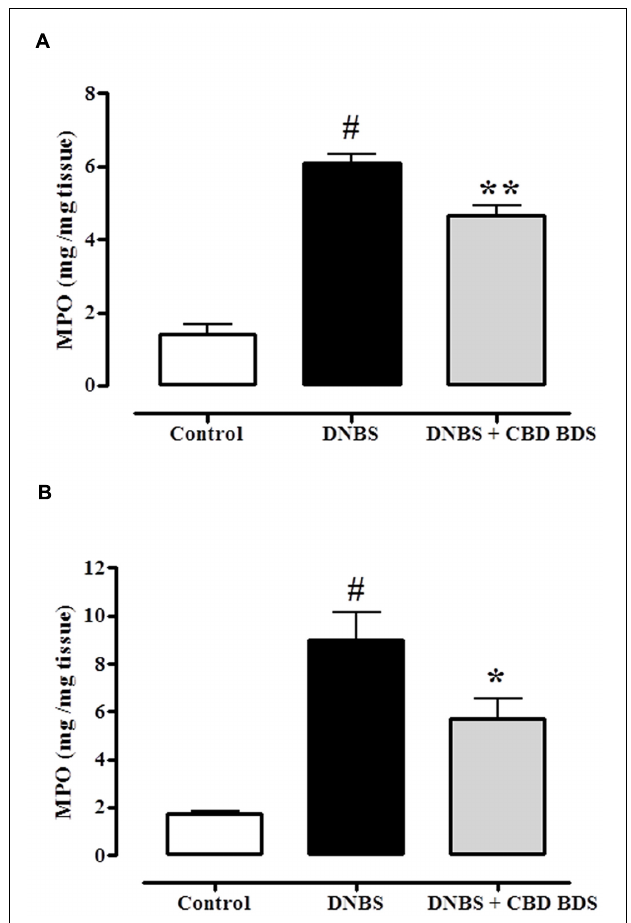
FIGURE 3 | Inhibitory effect of CBD BDS 30 mg/kg, intraperitoneally (A) and CBD BDS 60 mg/kg, by oral gavage (B) on myeloperoxidase (MPO) activity in DNBS induced colitis in mice (DNBS, 150 mg/kg, intracolonically). MPO activity was measured on colonic tissues 3 days after vehicle or DNBS administration. CBD BDS was given once a day for three consecutive days starting from 1 day after DNBS administration. Mice were euthanized 3 days after DNBS. Bars are mean ± SEM of 4–5 mice for each experimental group. # p < 0.001 vs. control and ∗ p < 0.05 ∗∗ p < 0.01 vs. DNBS